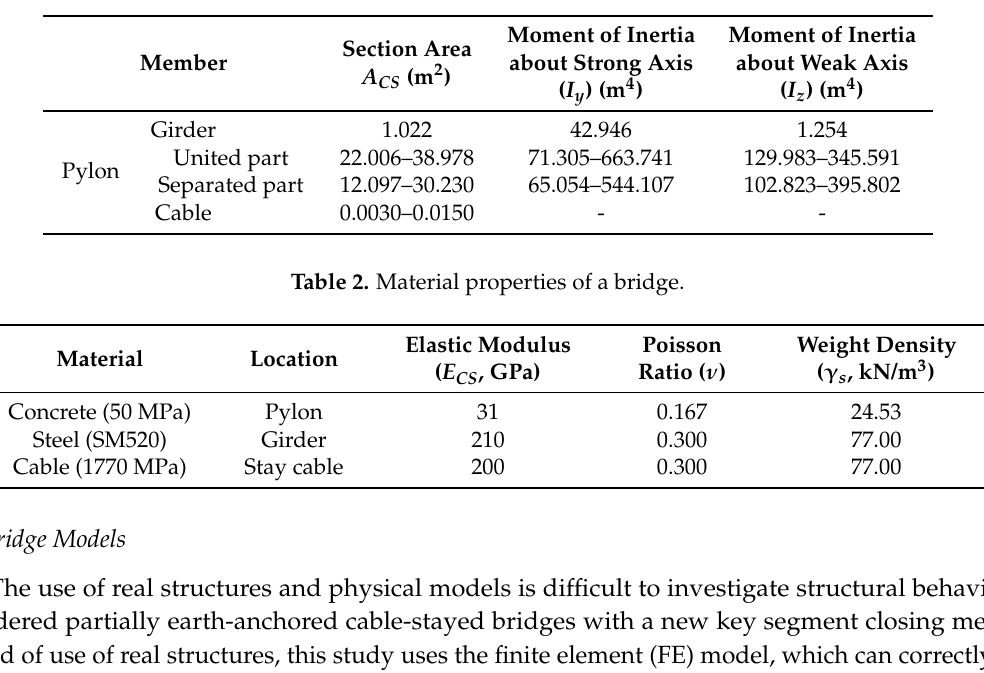
Table 1. Main sectional properties of a sample bridge.